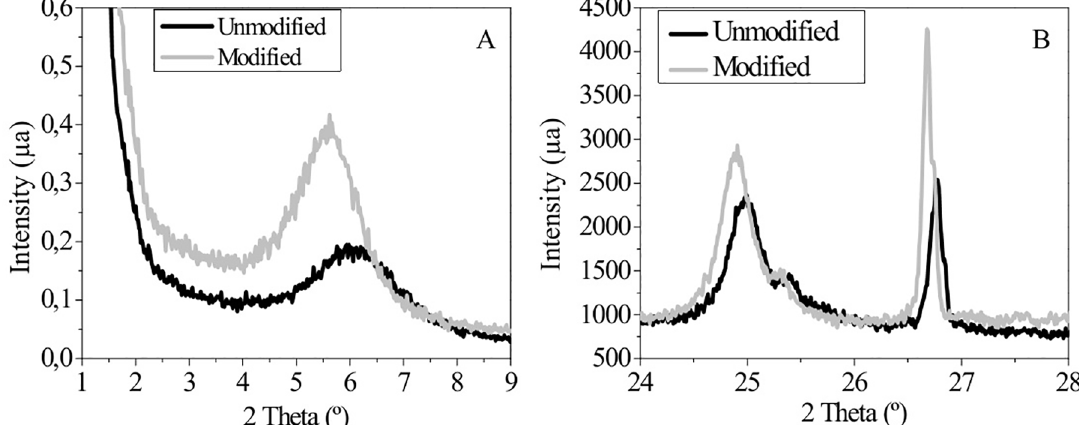
Figure 2. XRD A) Unmodified clay overlapped with cationic clay; B) Unmodified clay overlapped with anionic